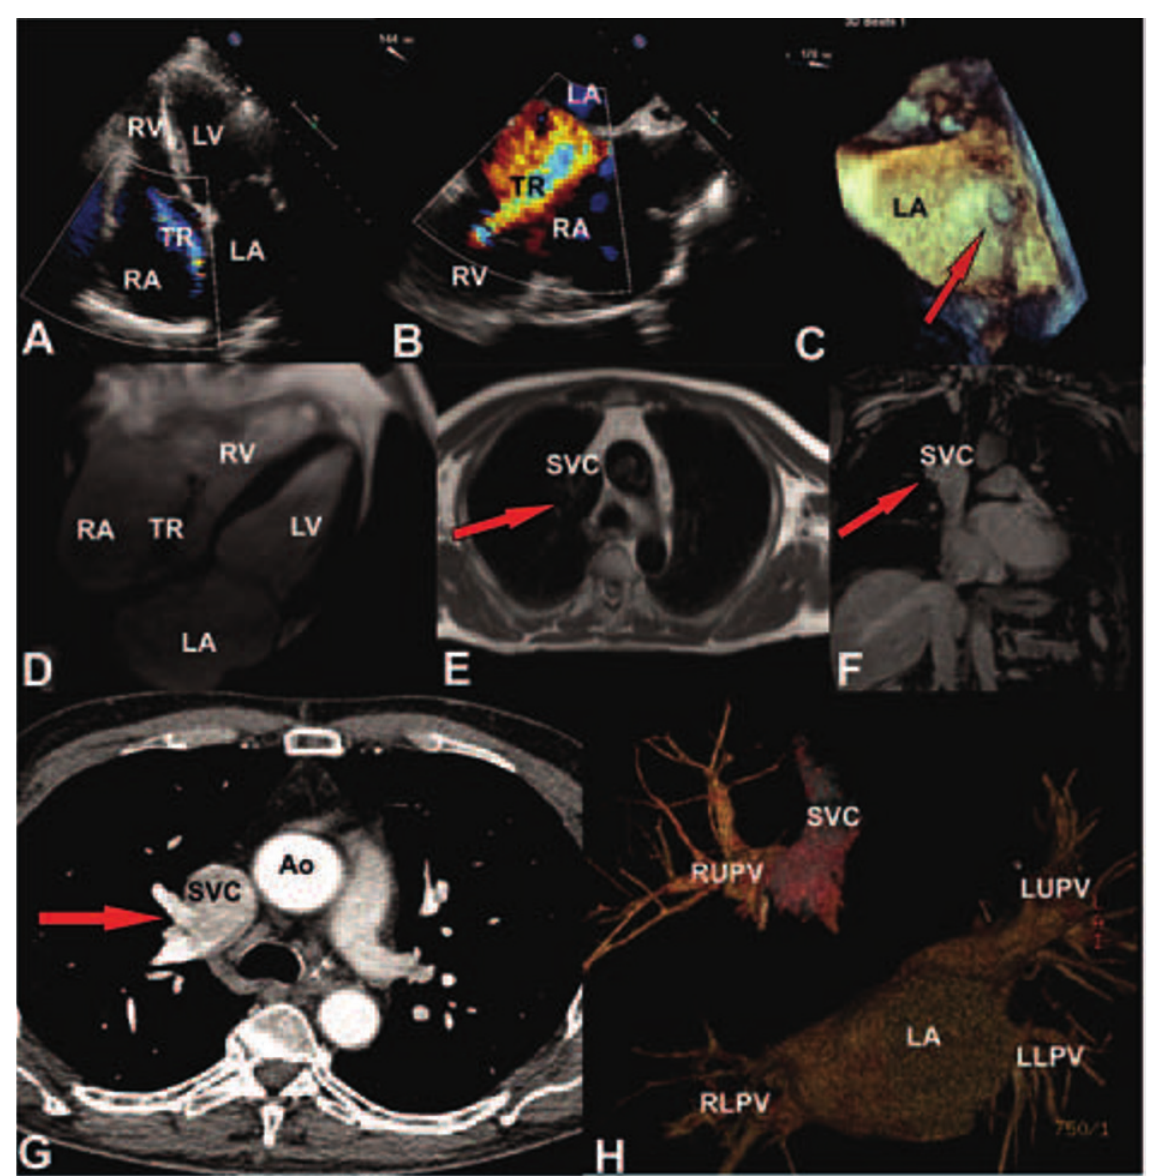
Figure 1. Ultrasound, CMR and CT images of 69-year-old male with isolated partial anomalous pulmonary venous connection. Figure 1A – apical four chamber heart view (TTE) showing atriomegaly and moderate-to-severe tricuspidal regurgitation (TR) (LA – left atrium, RA – right atrium, LV – left ventricle, RV – right ventricle). Figure 1B – the 2D TEE image showing intact atrial septum and moderate-to- severe TR. Figure 1C – 3D TEE image revealed only one right pulmonary venous entry (arrow). Figure 1D – four chamber CMR